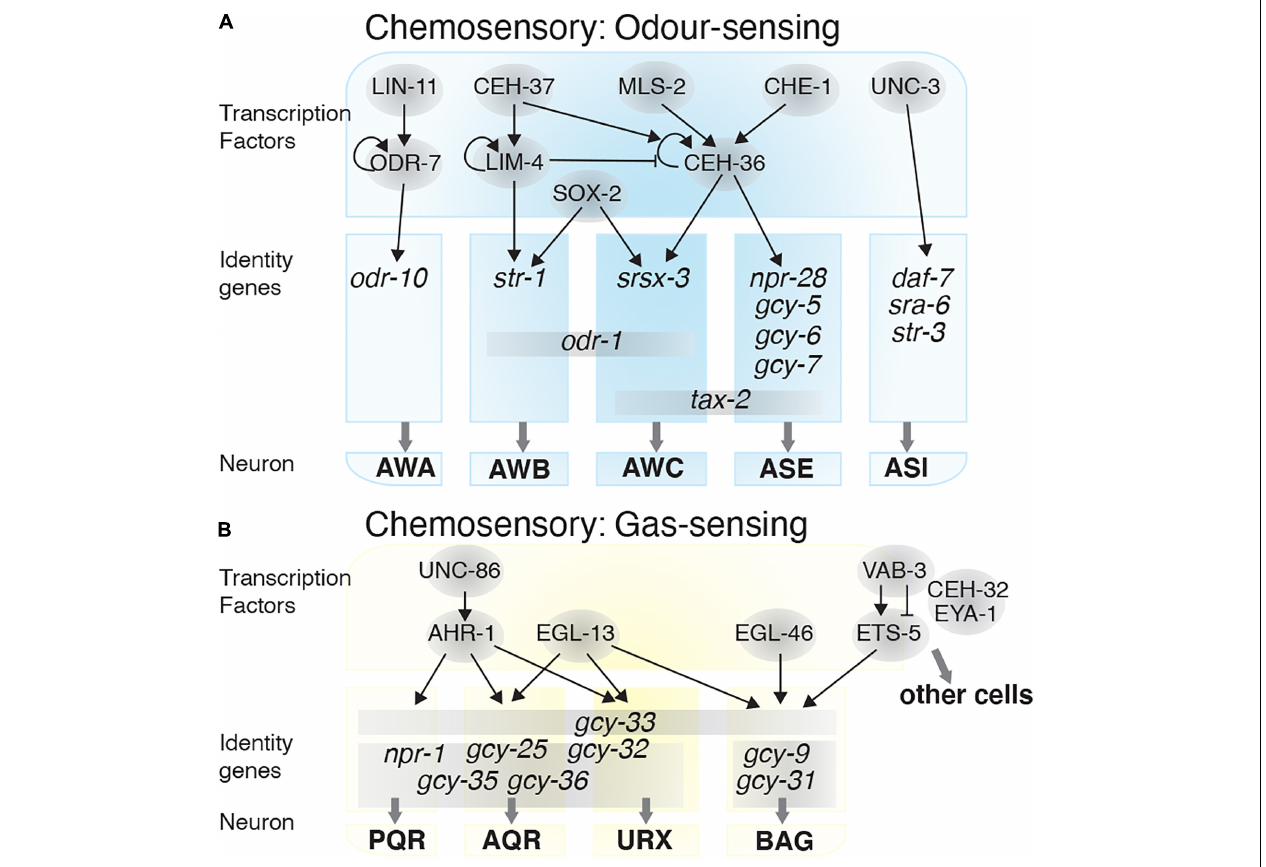
FIGURE 2 | Transcriptional regulatory networks in chemosensory neurons. Transcription factors are depicted in gray circles. How these transcription factors interact and the identity genes they regulate are shown for the: (A) Odor-sensing neurons and (B) gas-sensing